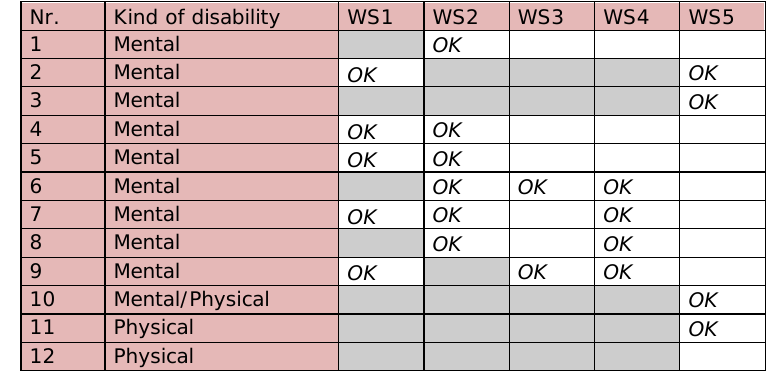
Table 2. Comparison of the initial and final